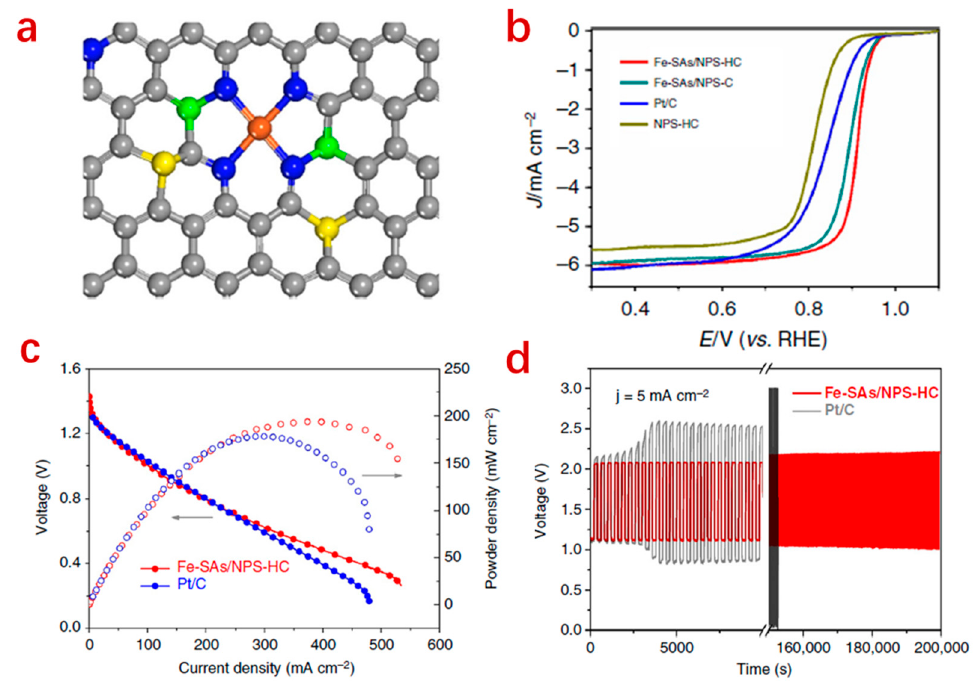
Figure 6. Structure of a ternary doped Fe–N x / C catalyst (Single iron atomic sites supported on a nitrogen, phosphorus and sulfur co-doped hollow carbon polyhedron (Fe–SAs / NPS)) (Fe (orange), N (blue), P (green), S (yellow) and C (gray)) ( a ), ORR performance comparison with single-doped and binary-doped analogues ( b ), and performance comparison for ZABs with these SACs and Pt / C catalysts, respectively ( c , d ) [78].